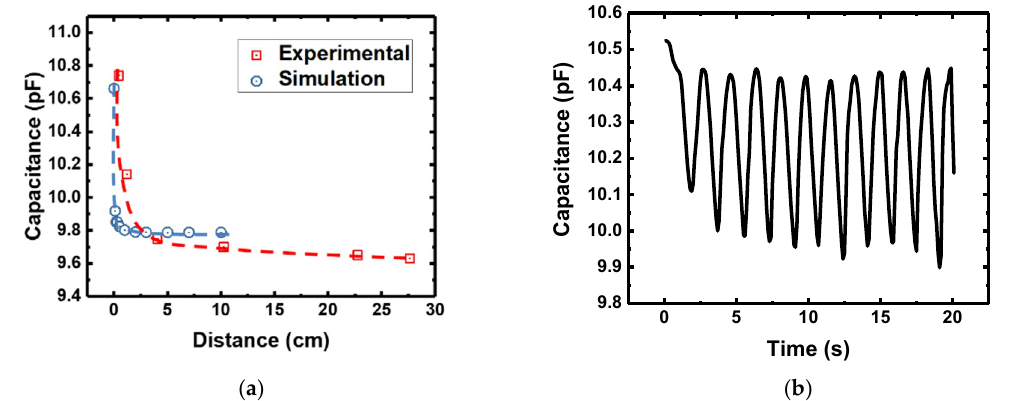
Figure 6 . ( a ) Measured capacitance w.r.t. various distances a human finger was placed from the IDE capacitor, and ( b ) transient capacitance plot when a human finger hovered above the IDE capacitor in a cyclic manner at a height of ~1–3 cm above .